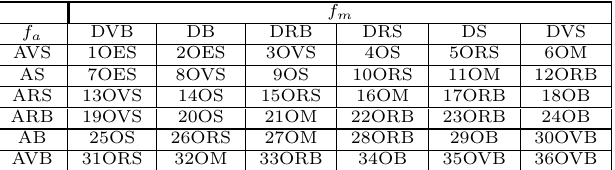
Table 2: fuzzy rules for adjust the mutation